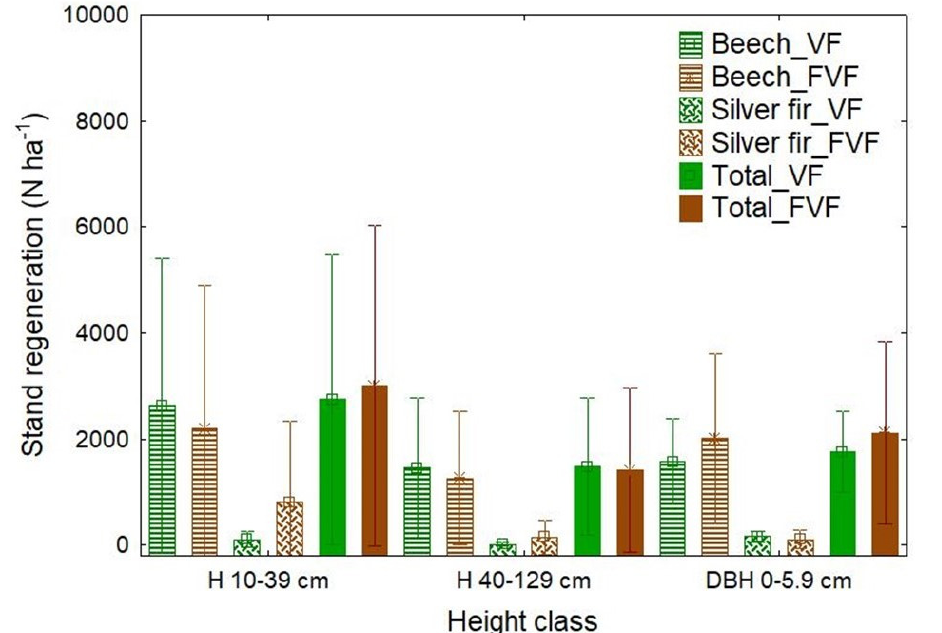
Figure 4. Density of saplings per forest type, species, and regeneration circle (RC1—5 m 2 for seedlings with height of 10–39.9 cm; RC2—10 m 2 for saplings 40–129.9 cm in height; RC3—20 m 2 for saplings with height >130 cm and dbh <6 cm). Error bars represent a 95% confidence interval. According to ANOVA–Tukey’s testing, there were no significant differences found ( p > 0.05) between the sampling category and forest type.